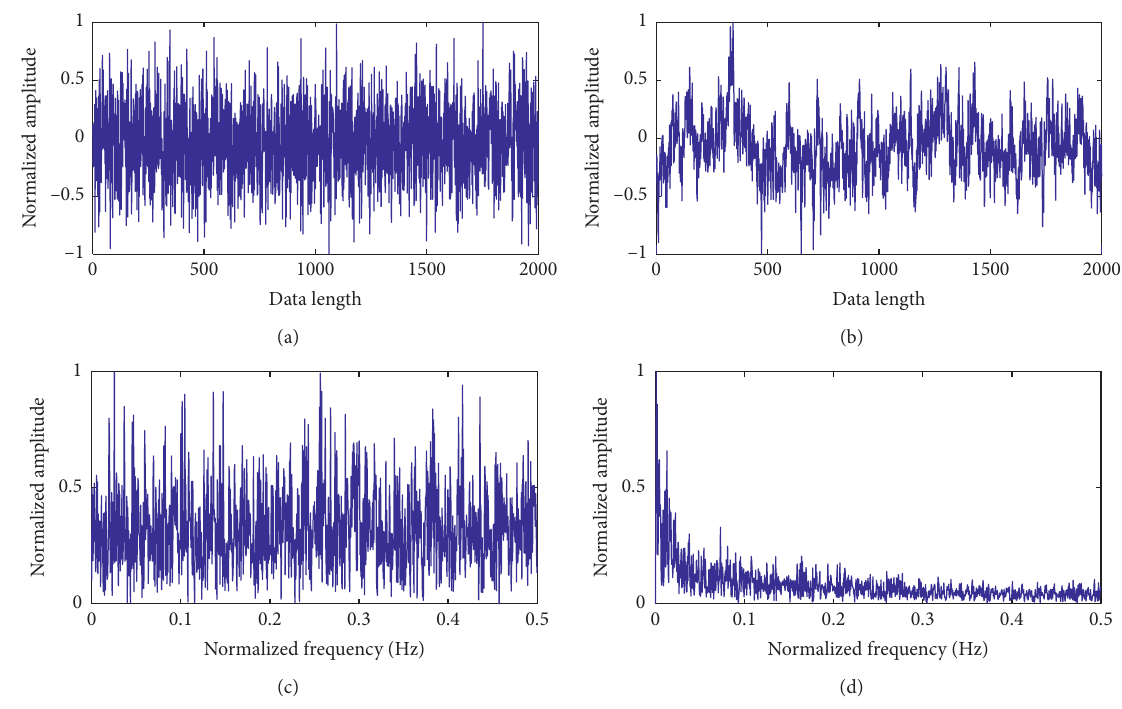
Figure 7: Waveform and spectrum of the simulation signal. (a) Temporal waveform of white noise, (b) temporal waveform of 1/ f noise, (c) FFT spectrum of white noise, and (d) FFT spectrum of 1/ f noise.